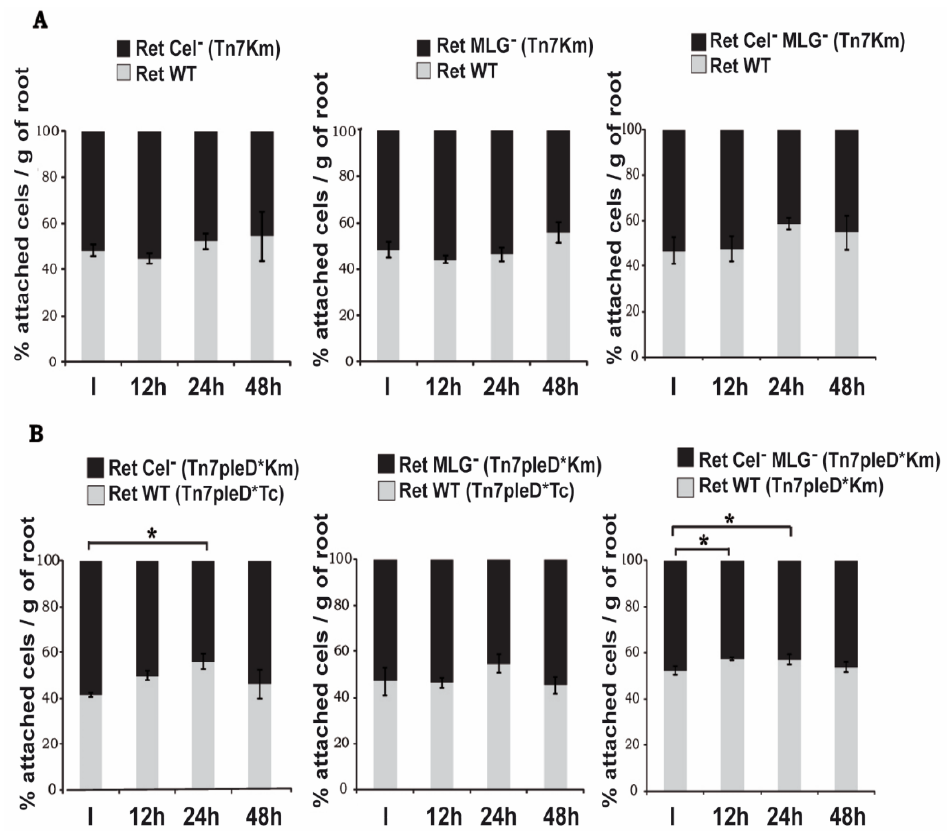
Figure 5. Role of β -glucans Cellulose and MLG in the adhesion of R. etli CFN42 to bean roots. 1:1 mixture (inoculum; I) of the different strains were in contact with bean roots for 12, 24, or 48 h. ( A ) Competitive adhesion under physiological conditions of c-di-GMP. ( B ) Competitive adhesion under of high levels of c-di-GMP conditions (presence of pleD* ). The bars indicate the proportion of CFU of the mutants (in black) and of the control strains (in grey) ± SEM. Asterisks indicate significant differences using an analysis of variance with a level of significance α= 0.1.